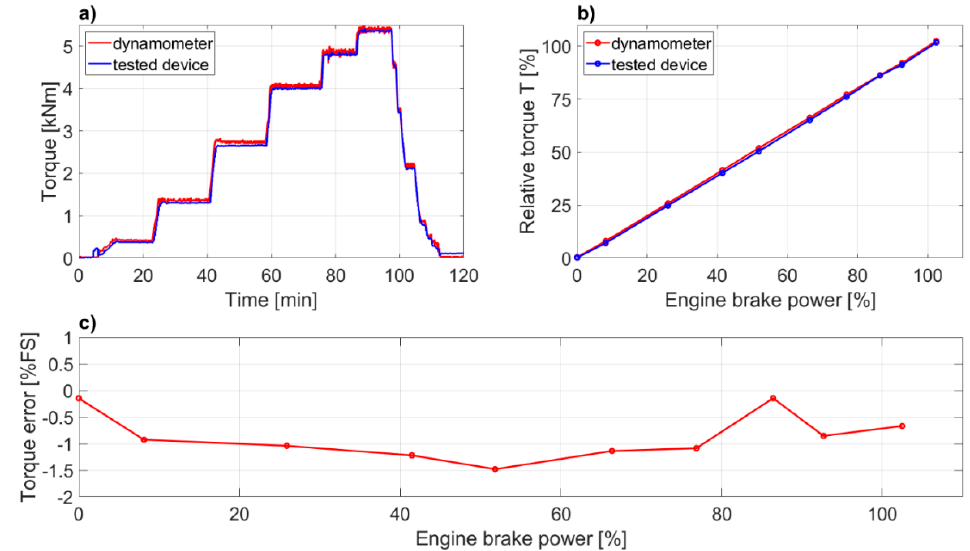
Figure 9. Comparison of proposed torque measurement device with the water brake dynamometer records: ( a ) time plots; ( b ) averaged values; and ( c ) proposed power meter device torque error in relation to dynamometer.